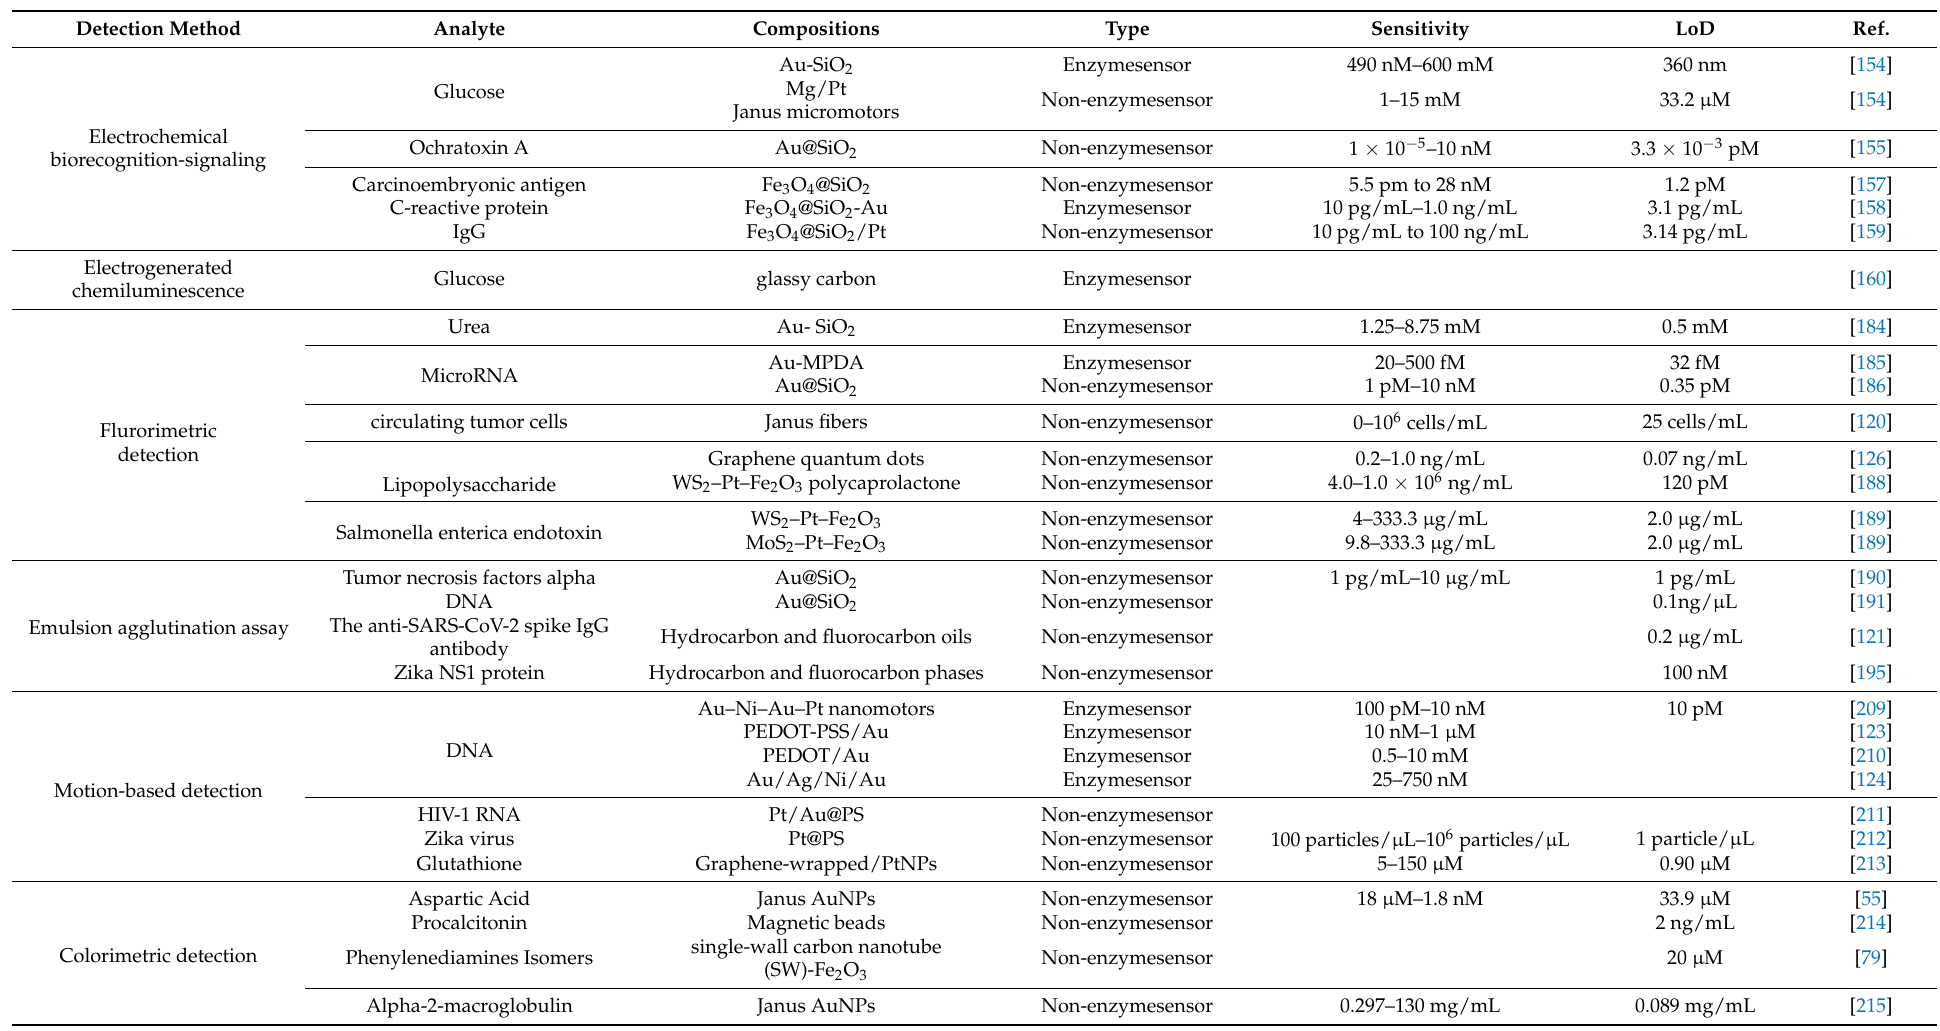
Table 2. Different sensing schemes for